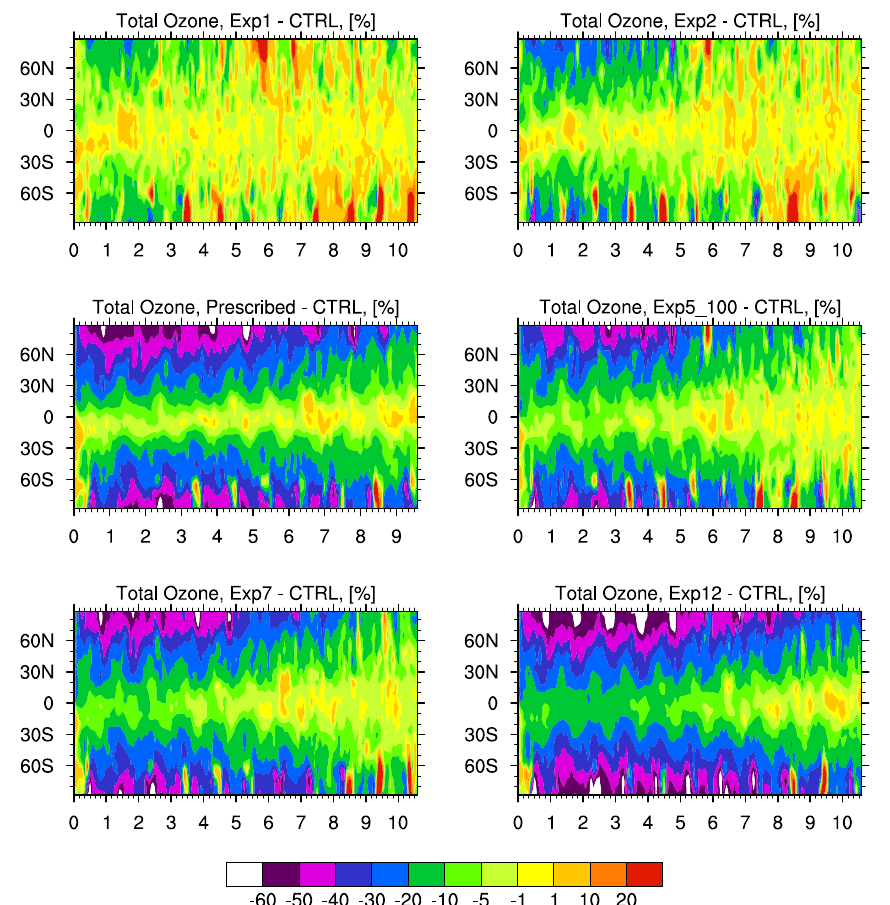
Fig. 13. Zonally averaged total column ozone deviations from the control simulation [ % ] as a function of latitude versus time for the simulations Exp1, Exp2, Prescribed, Exp5_100, Exp7, and